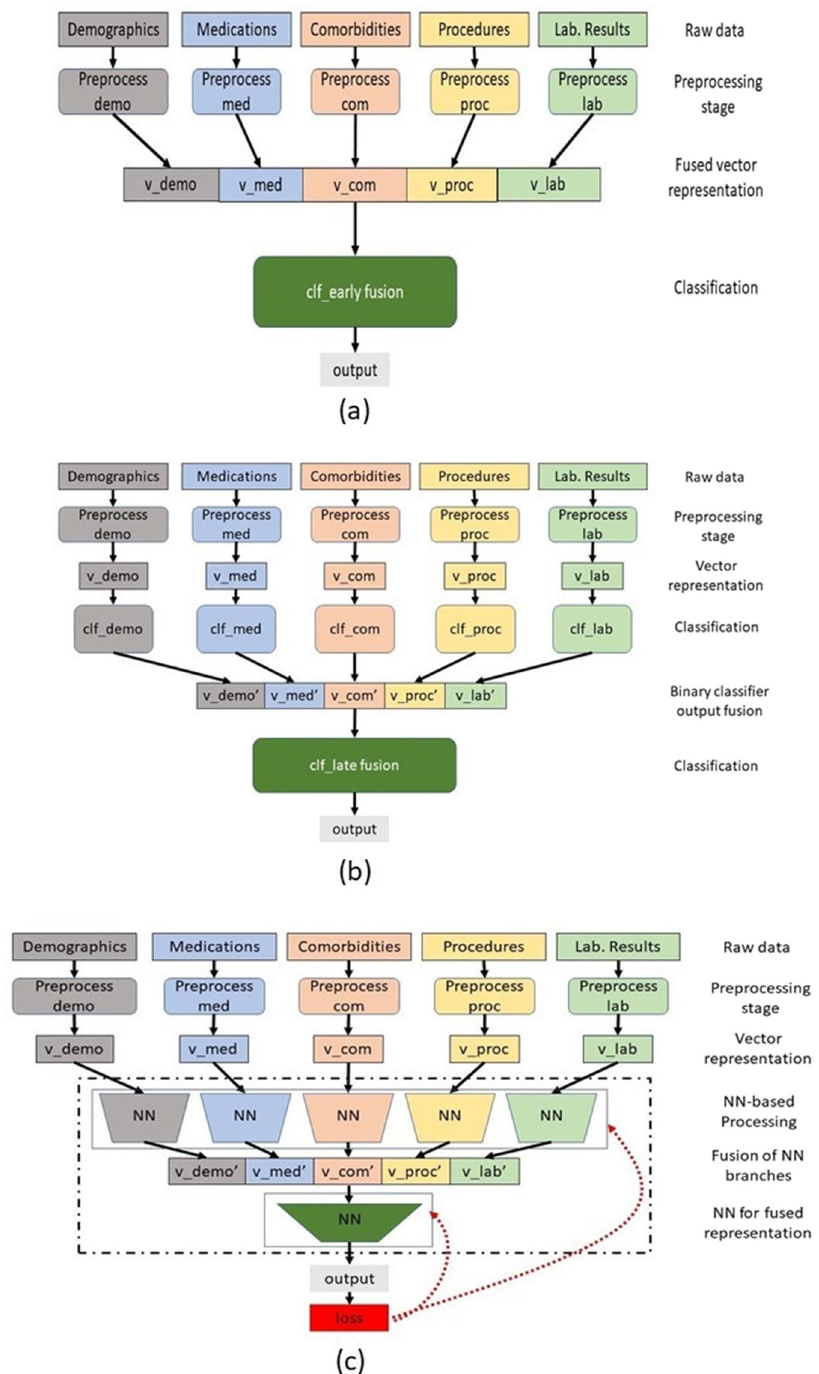
Fig. 5 Proposed fusion AI model architectures. a Early fusion, b late fusion, c middle fusion/branched NN